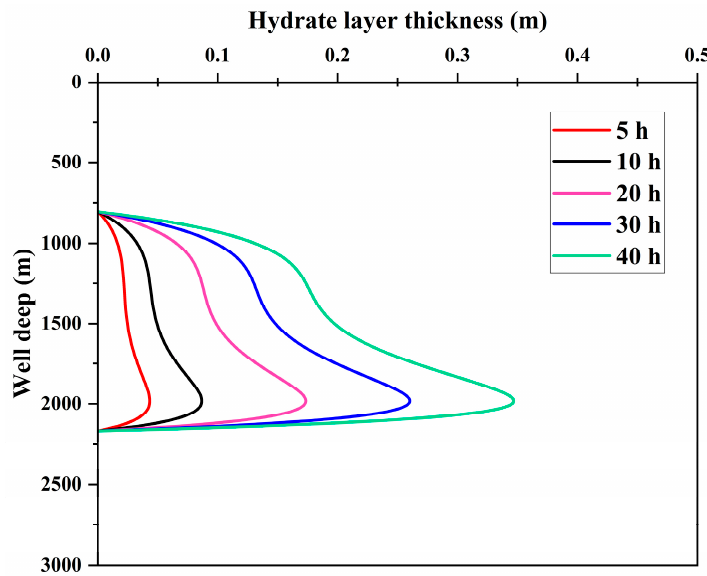
Figure 7. Variation of hydrated layer thickness with time under shut-in condition.